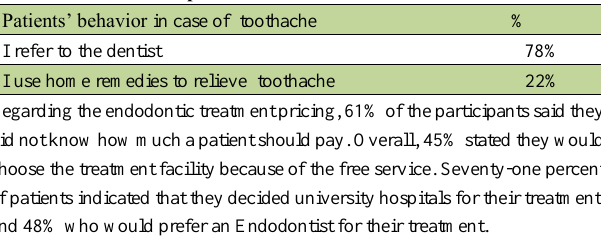
Table 4. Assessment of patients’ behavior in case of